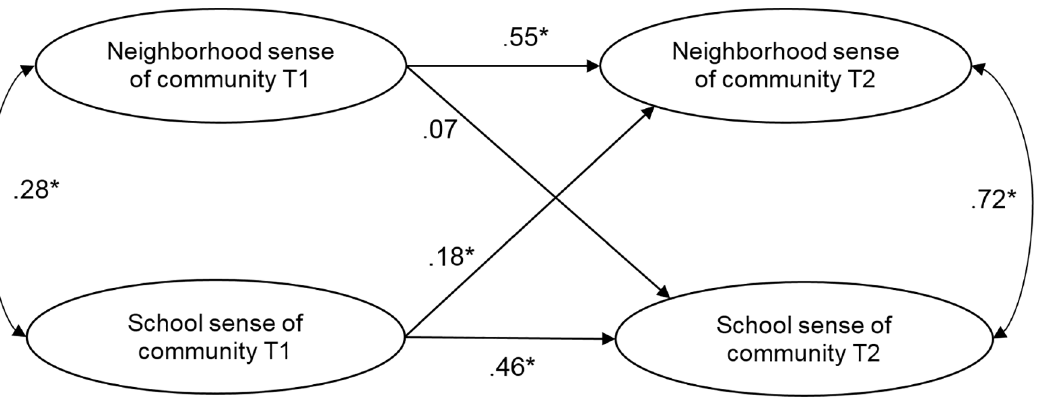
Figure 1. Cross-lagged relationships between neighborhood sense of community and school sense of community at Times 1 and 2 (χ 2 (1760) = 2143.67, p < .001; NNFI = 0.91; CFI = 0.91; RMSEA = 0.045). Note . Regression coefficients are